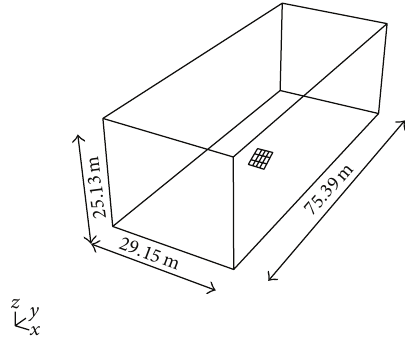
Figure 4: Arrayed set of solar panels and computational space used for analysis. The space geometry reads 75.39 m in length, 29.15 m in width, and 25.13 m in height.